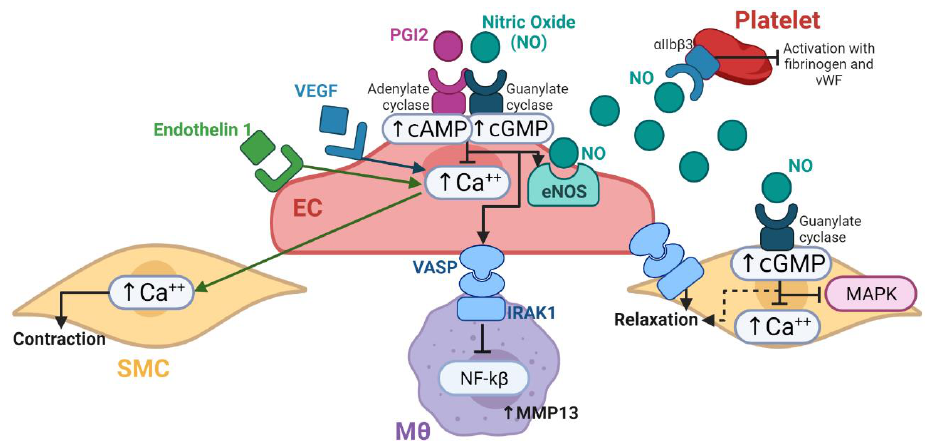
Figure 9. Endothelial cells’ regulatory activity in the vascular wall. Different stimuli induce the synthesis and release of nitric oxide (NO), which regulates the cells involved in the regeneration process of the vascular wall. Paracrine responses: 1. NO inhibits platelet activation when in contact with fibrinogen or vWF. 2. NO inhibits proliferatory pathways in SMCs and induces muscle relaxation. Autocrine response: NO induces the synthesis of the vasodilator-stimulated phosphoprotein (VASP). 1. VASP induces muscle relaxation. 2. VASP inhibits NFKβ activation in macrophages. Endothelial cells modulate thrombogenesis, muscle tone and inflammation (Created with BioRender.com, accessed on 3 February 2022).